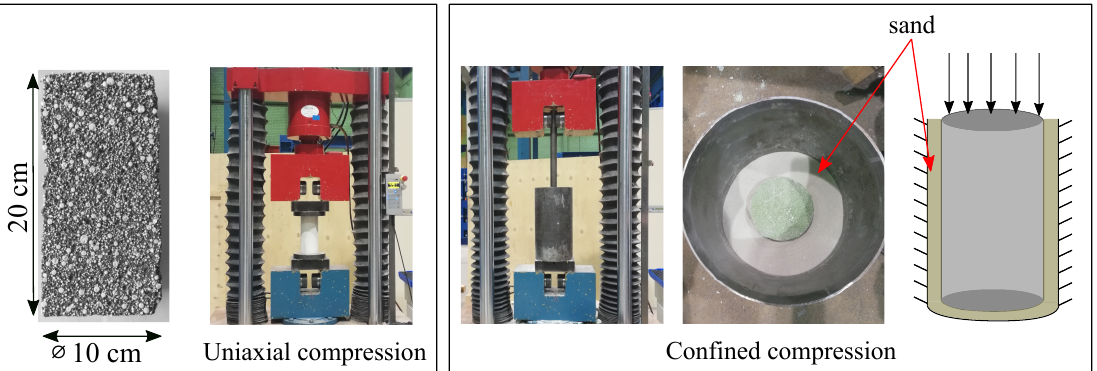
Figure 4. ( Left ): Sample geometry and experimental set-up for the uniaxial compression test. ( Right ): Experimental setup for the confined compression test.